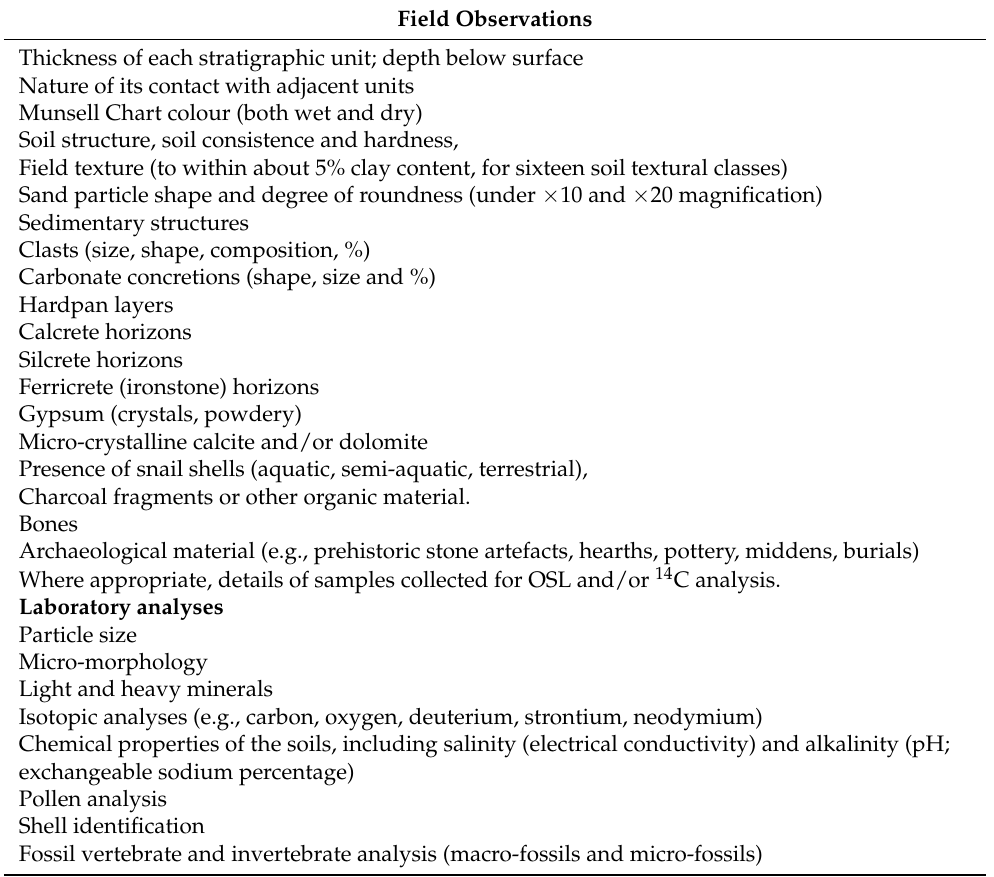
Table 2. Describing soils and sediments. (Based on [31,32], supplemented by the author’s field observations since 1962 in Africa, Asia and